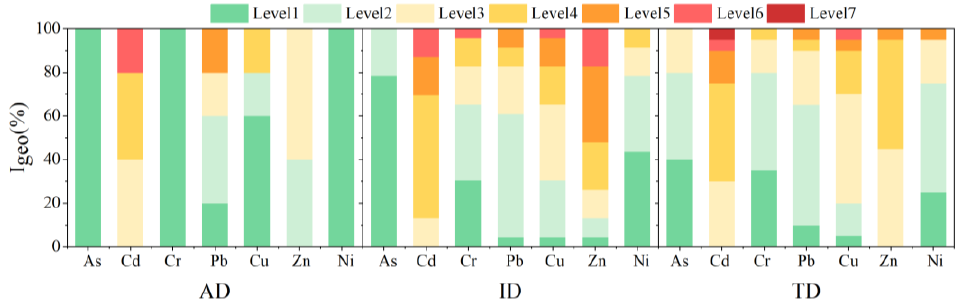
Figure 2. Geological accumulation index (I geo ) of trace metals in the road dust from the industrial park (ID), traffic intersection (TD), and agricultural field (AD) areas of Guangzhou.